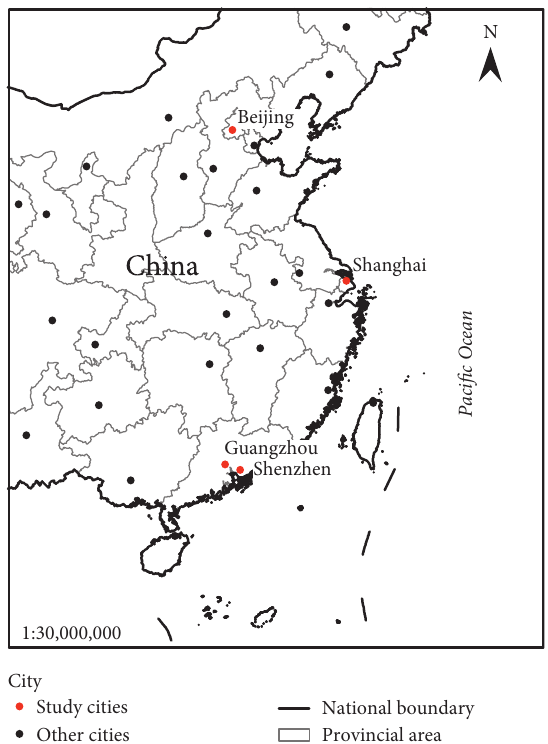
Figure 5: Locations of the study